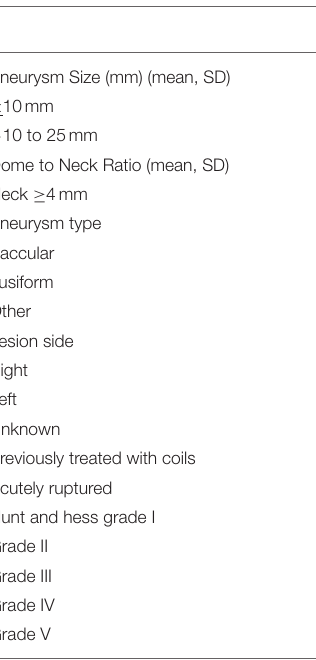
TABLE 2 | Aneurysm